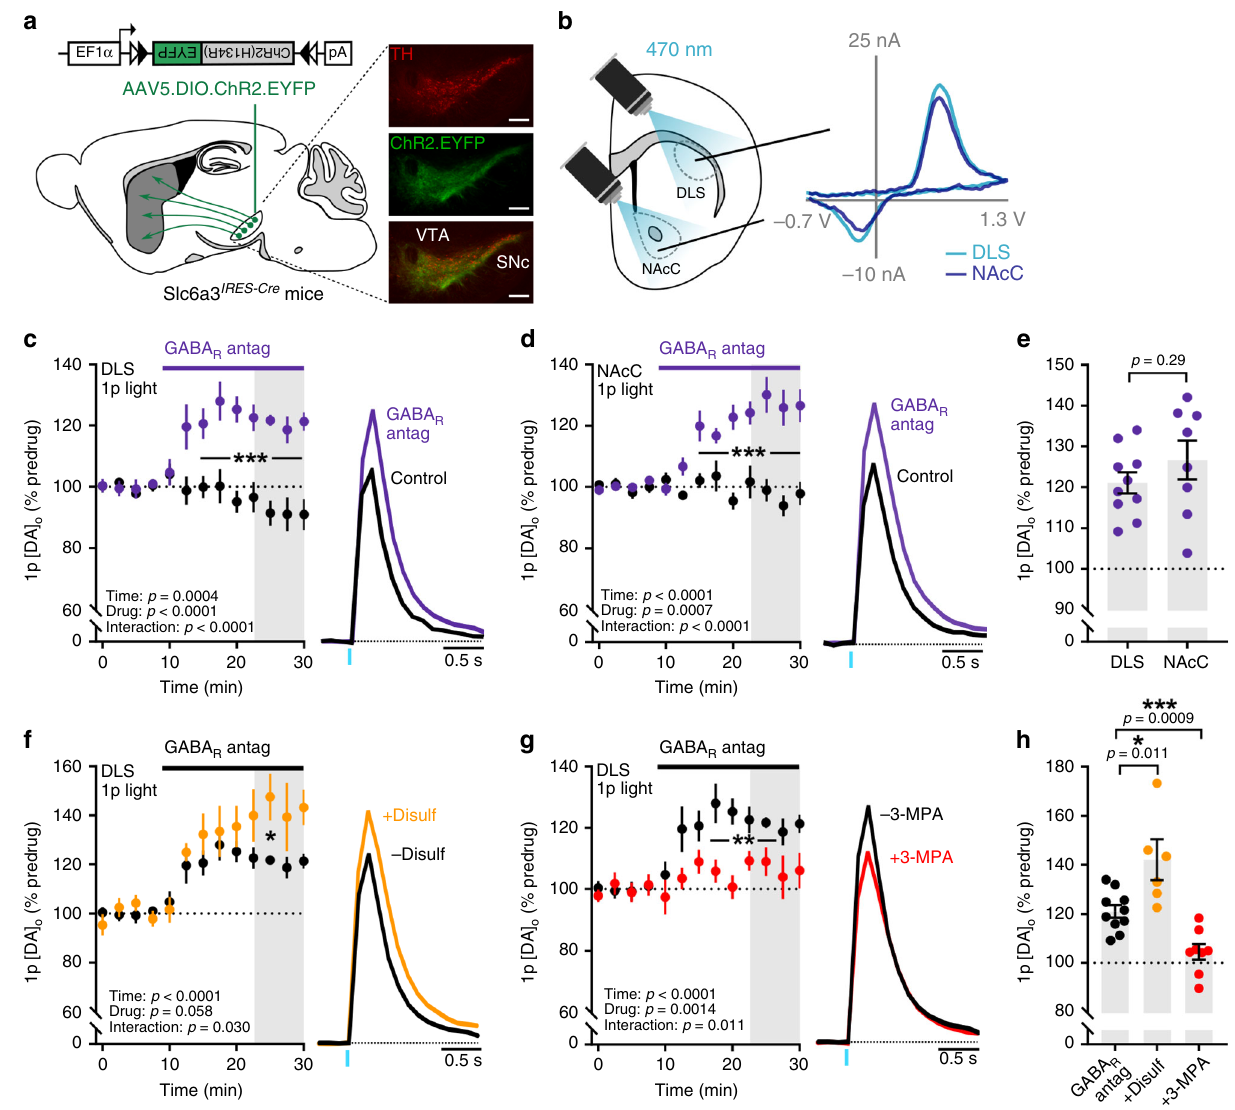
Fig. 1 Striatal DA release is tonically inhibited by a GAD-dependent GABA source. a , b Schematics representing the experimental con fi guration and representative voltammograms for light-evoked [DA] o in DLS and NAcC, after viral injection and expression of ChR2-eYFP in VTA and SNc in Slc6a3 IRES-Cre mouse. TH (red), ChR2-eYFP (green). Scale bars: 0.25 mm. c , d Left, mean peak [DA] o during consecutive recordings evoked by a single light pulse ( 1p ) in control conditions (black, n = 8 experiments/6 mice for DLS, n = 6 experiments/5 mice for NAcC) and with GABA A and GABA B receptor antagonists (solid bar)(purple, GABA R antag ), ( + )-bicuculline (10 μ M) and CGP 55845 (4 μ M), respectively, recorded in the DLS ( c , n = 10 experiments/6 mice) or NAcC ( d , n = 5 experiments/4 mice). Right, mean transients of [DA] o (normalized to predrug baselines) from last four timepoints (grey shaded region). e Mean peak [DA] o evoked by 1p light following GABA R antagonism in DLS and NAcC (as % of predrug baseline, data summarized from c and d ). f , g Mean peak [DA] o during consecutive recordings evoked by 1p during application of GABA R antagonists in the absence (black, n = 10 experiments/6 mice) or the presence of ALDH inhibitor disul fi ram (10 μ M) ( f , orange, n = 6 experiments/5 mice) or GAD inhibitor 3-MPA (500 μ M) ( g , red, n = 7 experiments/5 mice). h Mean peak [DA] o in DLS following GABA R antagonism in the absence or the presence of 3-MPA and disul fi ram (as a % of predrug baseline, data summarized from f and g ). Data are normalized to mean of four timepoints prior to GABA antagonist application (dotted line). Mean transients of [DA] o are derived from last four timepoints (grey shaded region) and normalized to predrug baselines. Two-way repeated-measures ANOVA with Sidak ’ s multiple comparison tests ( c , d , f , g ) and two-tailed Student ’ s unpaired t -tests ( e , h ). * p < 0.05, ** p < 0.01, *** p < 0.001. Control data in f and g are the GABA R antagonist data from c . Error bars are ±SEM. Source data are provided as a Source Data fi le.